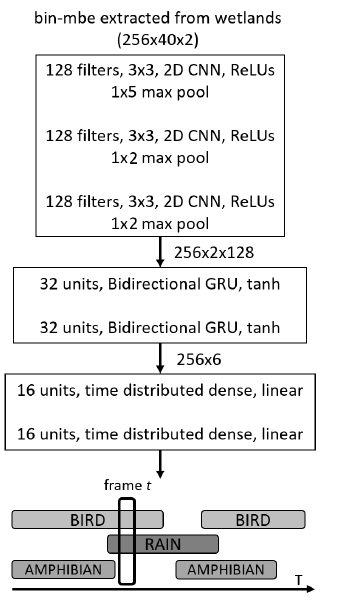
Figure 7. SEDnet